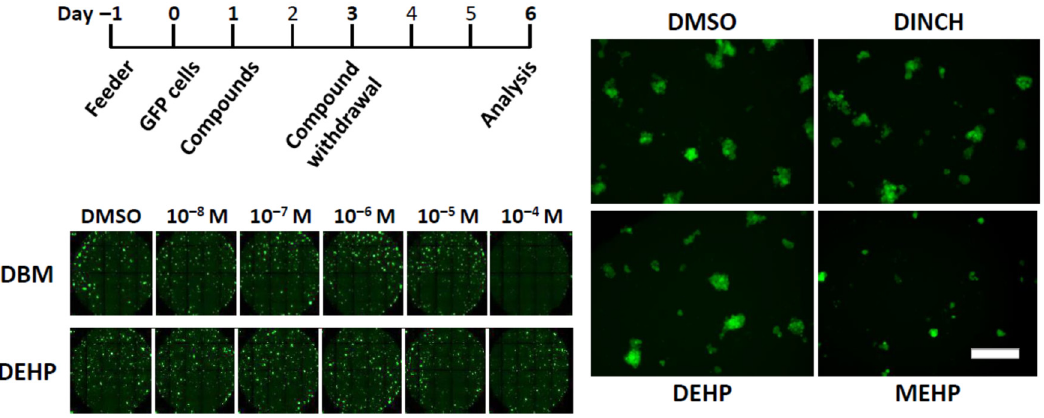
Figure 1. Automated image capture of clusters after short-term exposure to plasticizers. ( Top Left ) Culture schedule of the short-term exposure scheme. Feeder layers were prepared a day before placing GFP cluster cells in culture, while compounds were added a day after cell seeding. Compounds were withdrawn on day 3 and media and growth factors are replenished. Images were acquired on day 6. ( Bottom Left ) Representative composite image of cluster cultures exposed to different ranges of compound concentrations. Each dot with green fluorescent signal represents one cluster. DBM and DEHP are shown here as examples, which were added at the concentration of 10 − 8 M to 10 − 4 M. ( Right ) A panel of representative image of GFP clusters exposed to DMSO, DINCH, DEHP, or MEHP at 10 − 4 M. Scale bar = 20 µm.